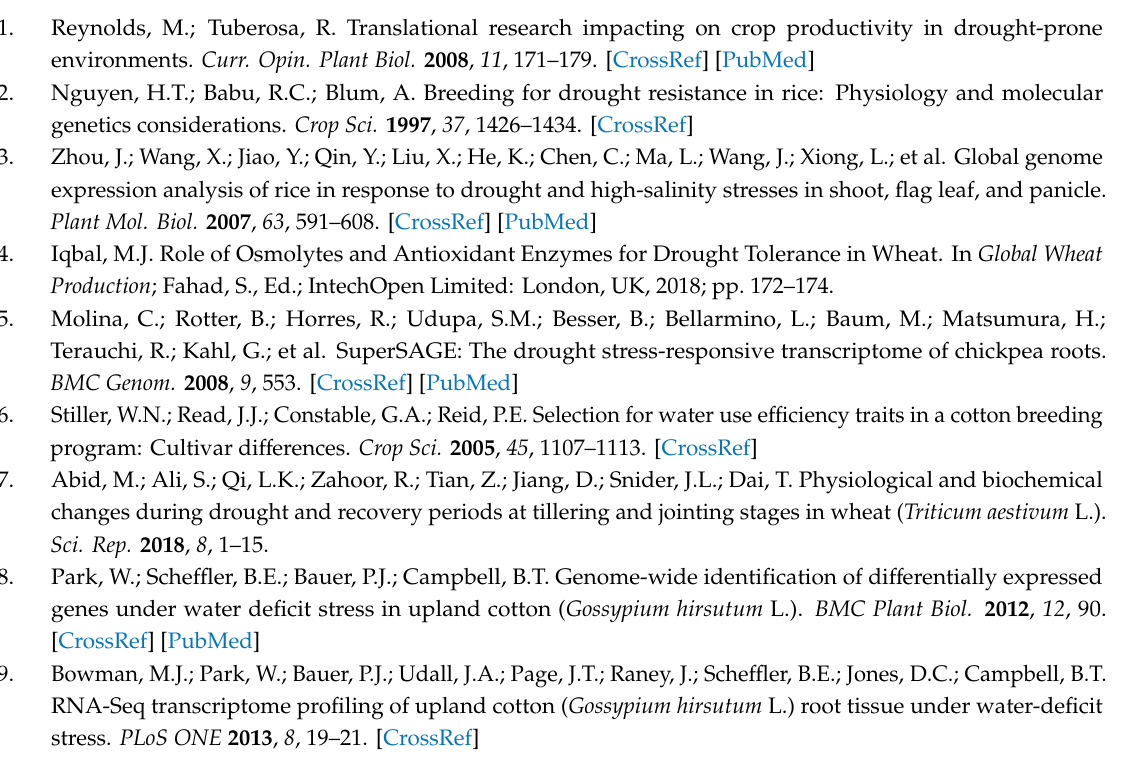
s1. Figure S1. RPKM plot box distribution of three cotton species. Figure S2. RPKM density distribution in three cotton species. Figure S3. Distribution of reads in di ff erent regions of three cotton genome. Figure S4. Percent error rate saturation curve. Figure S5. Venn diagram is showing that total of 6968 DEGs. Figure S6. Di ff erential expression genes MA plot and volcano plot. Figure S7. Cluster analysis of DEGs under GO terms is depicted in the Heat map. Table S1–S6: Zip file of all related data set and name